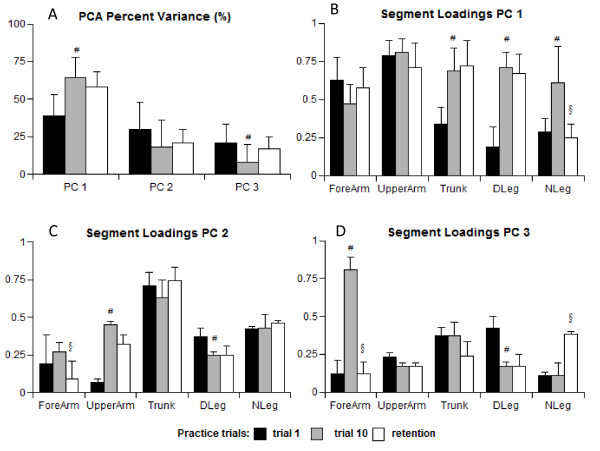
Means and standard deviations of the percentage of variance explained by the first 3 PCs (A), and segmental loadings of the dominant forearm, upper arm, trunk, dominant and non-dominant legs on the first 3 PCs during the first (B), last (C), and retention (D) trials. * identifies significant difference between the first trial and the trial where significant changes occurred; #- identifies significant difference between the first and the last trial; §-identifies significant difference between the last and retention trials. The differences are indicated for the PCs loadings coefficients exceeding 0.7.